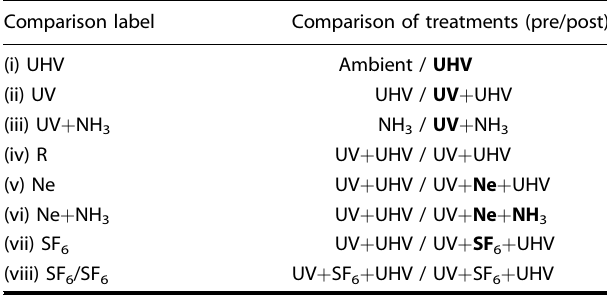
Table 1. List of treatment comparisons. Comparison